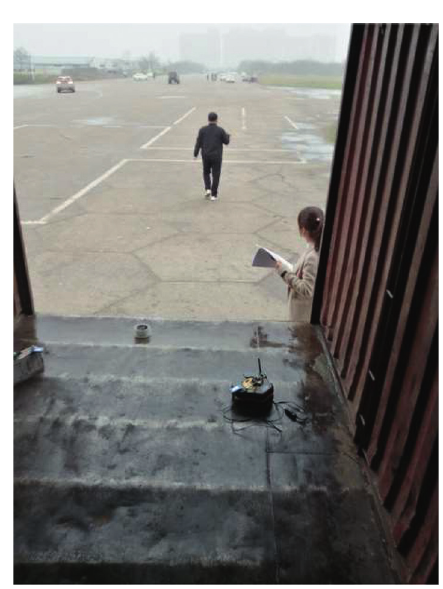
Figure 11: Movement of a single